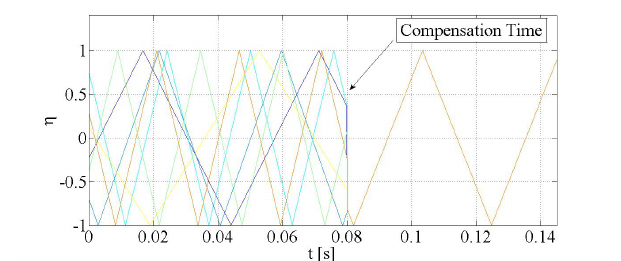
Figure 17. The PWM modulation waveform signals of the six node with centralized topology, with tdel = 10 − 4 s